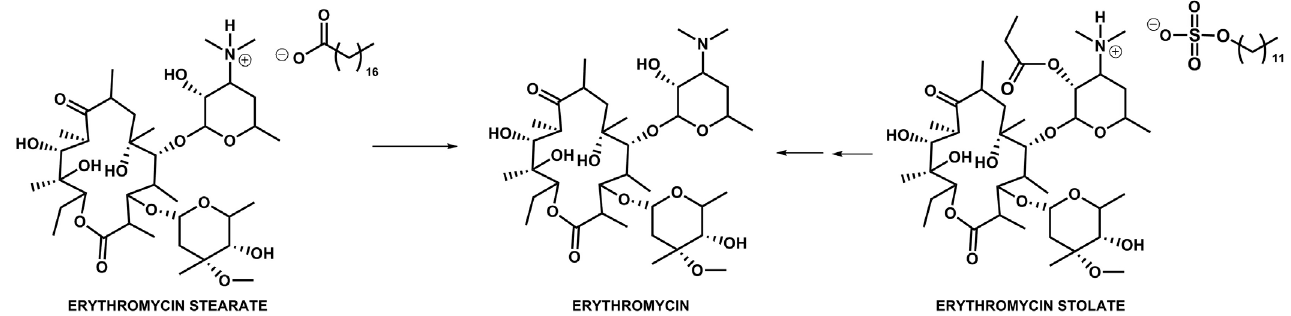
FIGURE 25 - Conversion of erythromycin stearate and erythromycin estolate into